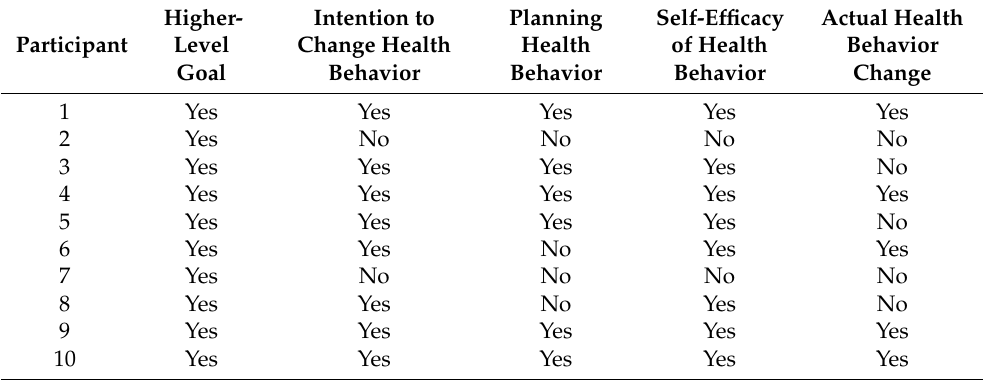
Table 4. Overview of higher-level goal, intention to change health behavior, planning, and self-efficacy of health behaviors, and actual health behavior change during pregnancy of the ten participants. Intention to Higher- Change Health Participant Level Behavior Goal